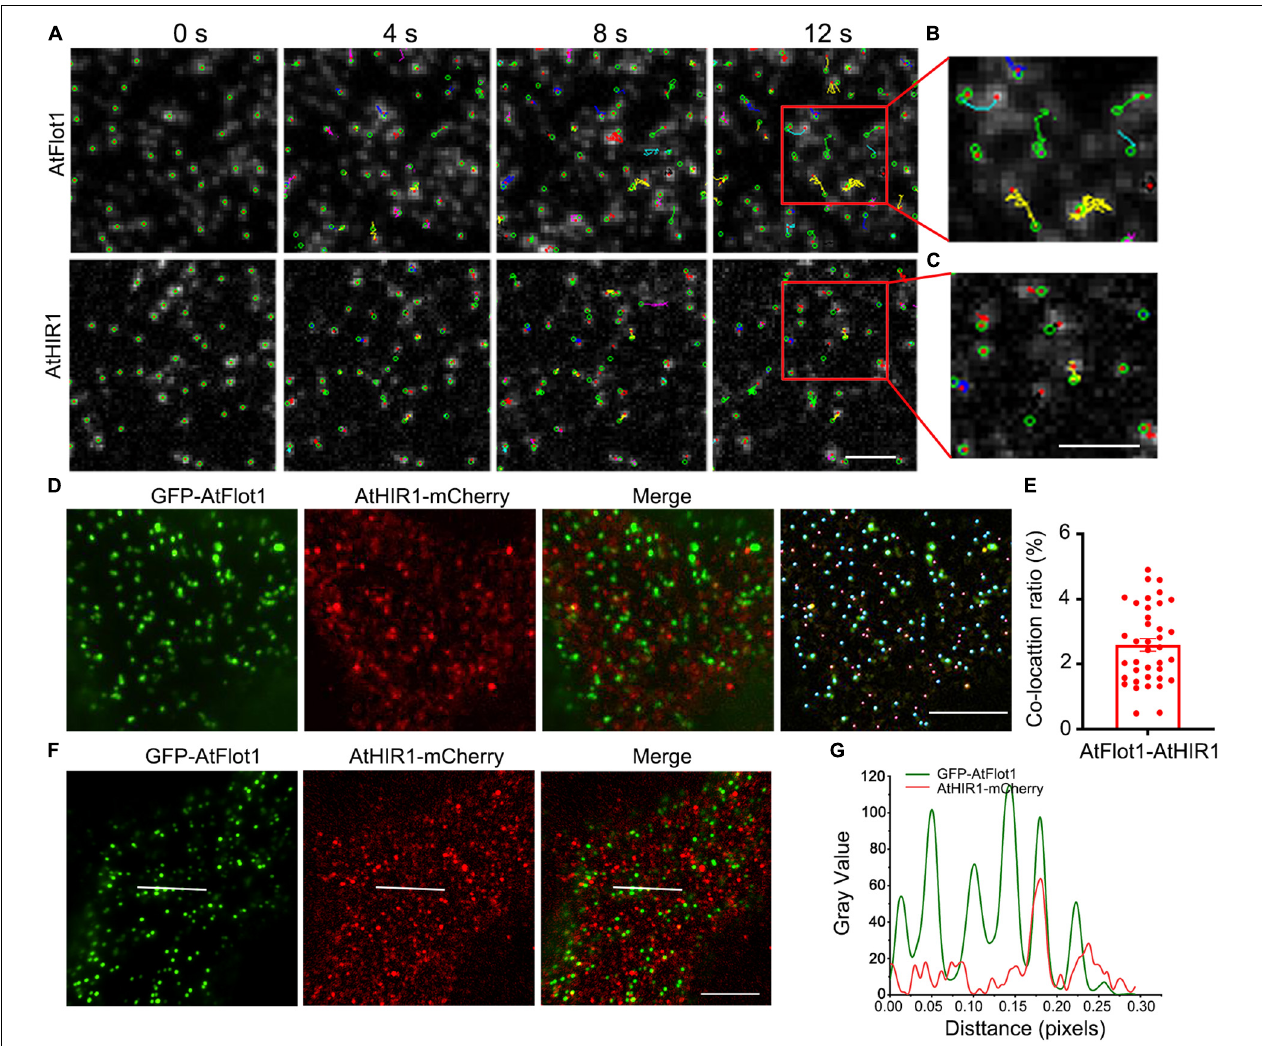
FIGURE 2 | TIRFM analysis of the association of AtFlot1 and AtHIR1 proteins. (A) Time-lapse trajectories of AtFlot1/AtHIR1 foci shown at different time points (0, 4, 8, and 12 s). The foci moved over a significantly wider area in AtFlot1 plants, and AtHIR1 foci showed smaller movements. Bar = 1 µ m. (B,C) The trajectory of fluorophore-tagged molecules from the area indicated by the red box in (A) , showing varied trajectories among different spots. Bar = 1 µ m. (D) VA-TIRFM images of leaf epidermal cells co-expressing GFP-AtFlot1 and AtHIR1-mCherry. The cyan ball represents GFP-AtFlot1 and the carmine balls represent AtHIR1-mCherry. Bars = 5 µ m. (E) Histogram showing the ratios of co-localization between GFP-AtFlot1 and AtHIR1-mCherry. For each examination, at least 30 cells from each of five seedlings were examined. In each case, three biological replicates were performed. (F) Colocalization of GFP-AtFlot1 foci with AtHIR1-mCherry foci. The white line indicates fluorescence signals. Bar = 5 µ m. (G) GFP-AtFlot1 and AtHIR1-mCherry fluorescence signals for the events shown in (F) . The green line indicates GFP-AtFlot1, and the red line indicates